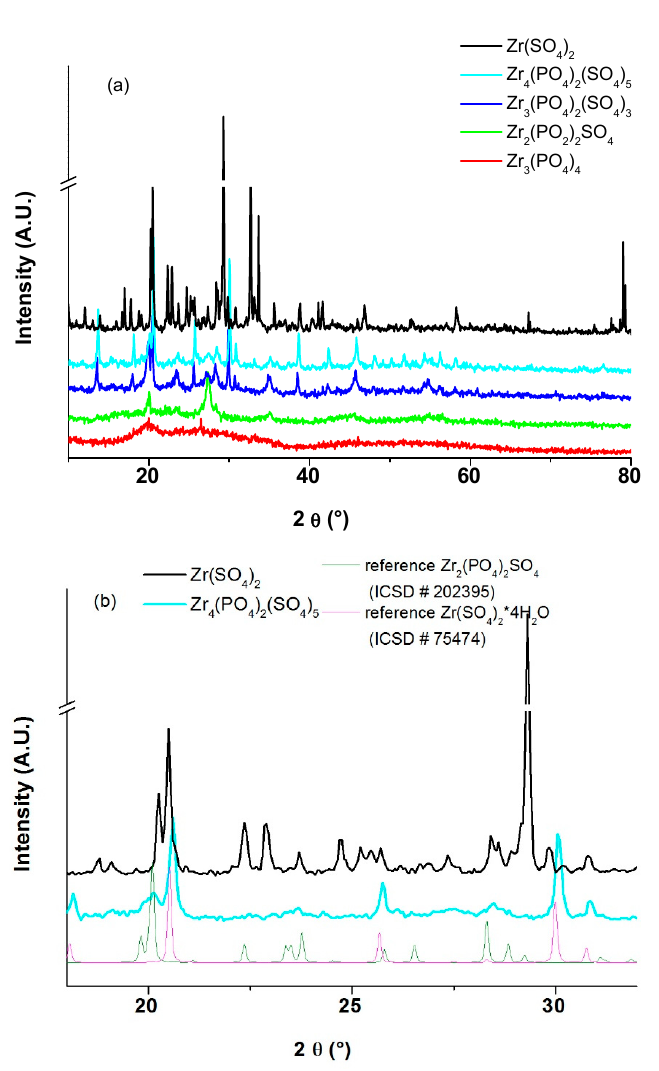
Figure 3. ( a ) XRD patterns of the Zirconium Phosphate-Sulphate catalysts. ( b ) XRD enlarged patterns of Zr(SO 4 ) 2 and Zr 4 (PO 4 ) 2 (SO 4 ) 5 along with the reference files, Zr 2 (PO 4 ) 2 SO 4 (ICSD #202395) and Zr(SO 4 )2·4H 2 O (ICSD #75474).